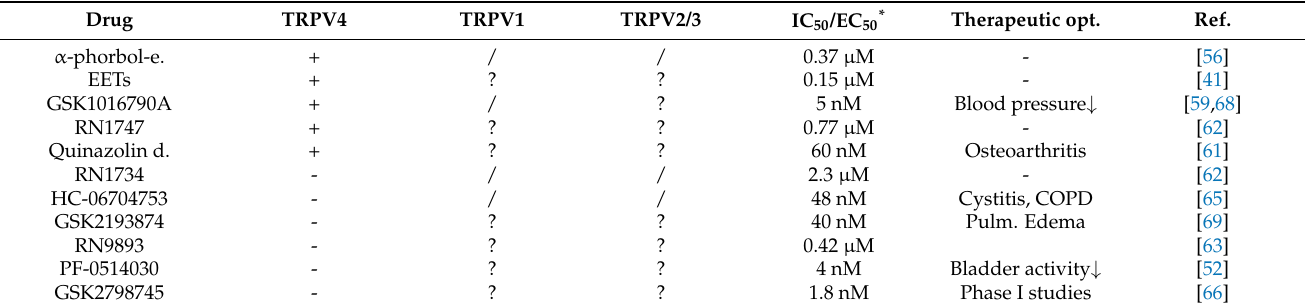
Table 1. Selected compounds activating or inhibiting TRPV4 channels (modified from Reference [67]). Drug TRPV4 TRPV1 TRPV2/3 IC 50 /EC 50* Therapeutic opt. Ref. α